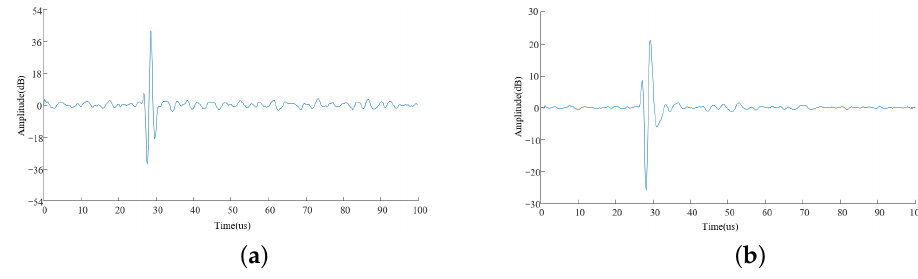
Figure 7. Experiment results (( a ) V102-RB (35.6 dB) and ( b ) developed transducer (20.4 dB)).